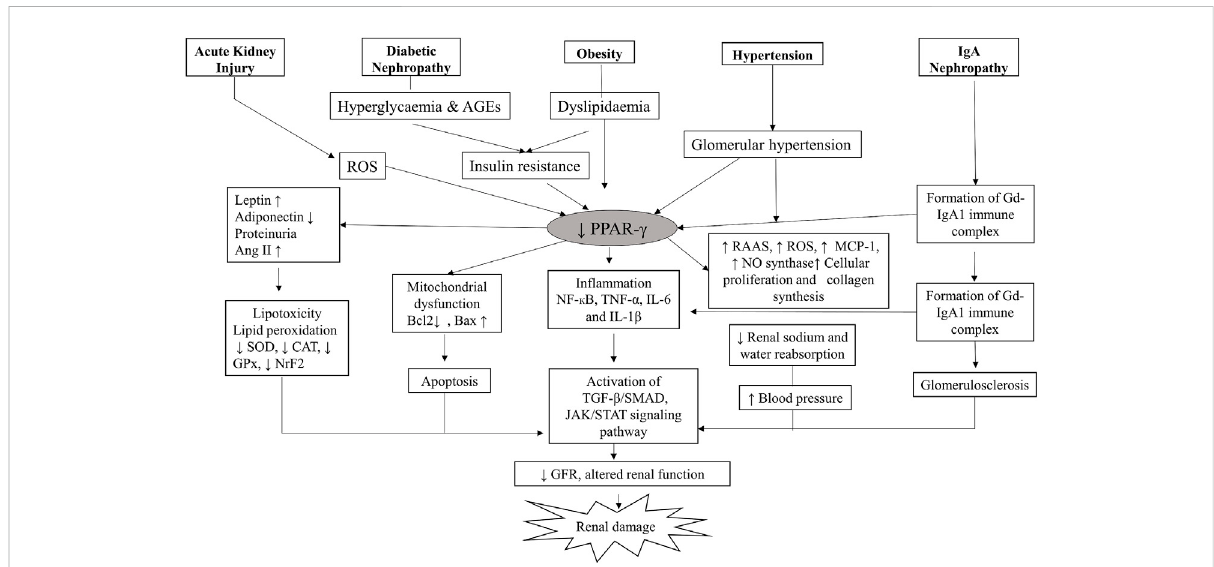
FIGURE 3 Role of PPAR- γ in the pathophysiology of kidney diseases. The suppression of PPAR- γ in disease conditions further activates the in fl ammatory and fi brogenic factors leading to kidney damage. AGE, Advanced glycation end products; BAX, BCL2-associated X protein; BCL-2, B-cell leukemia/ lymphoma 2; CAT, Catalase; GPx, Glutathione peroxidase; GFR, Glomerular fi ltration rate; IL-6, Interleukin-6; IL-1 β , Interleukin-1 β , IgA1, Immunoglobulins A1; MCP1, Monocyte chemoattractant protein-1; NF κ B, Nuclear factor-kappa B light-chain-enhancer of activated B cells; NO, Nitric oxide; NrF2, Nuclear factor-erythroid factor 2-related factor 2; ROS, Reactive oxygen species; RAAS, Renin-Angiotensin-Aldosterone System; SOD, Superoxide dismutase; STAT, Signal transducer and activator of transcription; TGF β , Transforming growth factor-beta; TNF α , Tumor necrosis factor-alpha.